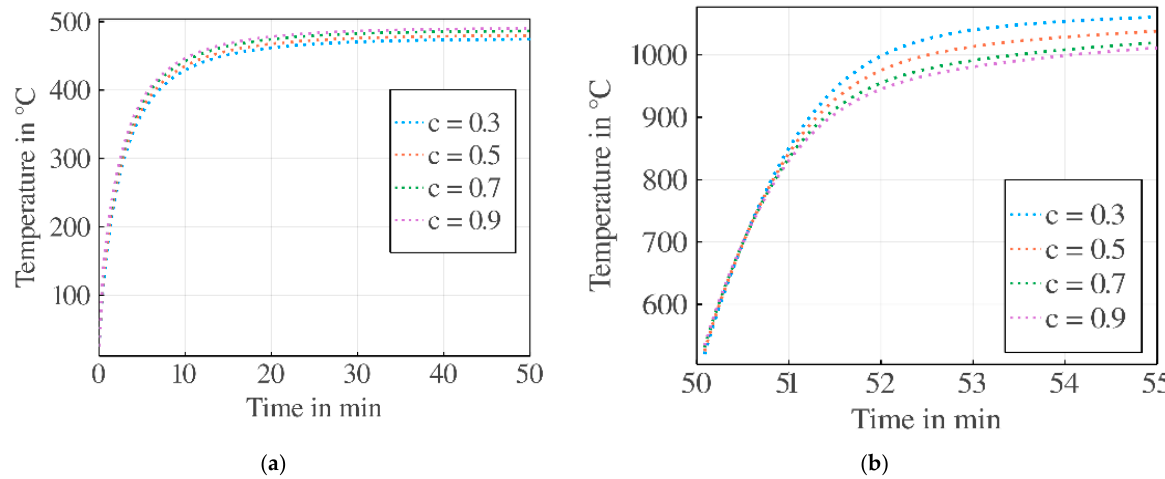
Figure 16. Scrap (S3) preheating temperature development for different 𝑐 values over the time of ( a ) phase 1 and ( b ) phase 2.